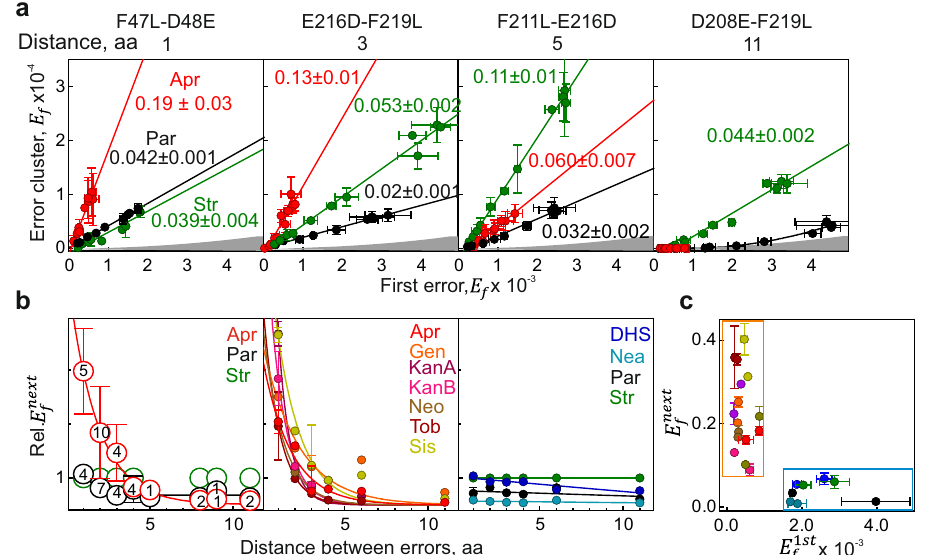
Fig. 5 Distance dependence of successive errors. a Correlation between E 1st f and E cluster f for different AGAs and clusters. Slopes of the linear plots yield the E next n = 3). Expected stochastic level of error clusters is indicated as gray area. b Distance f values. Shown are means ± SD of three technical replicates ( dependence of error cluster formation. Left panel: Distance dependence E next f for Apr, Par, and Str. Data from Figs. 4a, d, 5a, and Supplementary Figs. 7a, 8. The probability for error cluster formation is normalized to that of Str value, which has very little distance dependence and is set to 1 ( ‘ Methods ’ ). The number of clusters is indicated inside the symbols. When more than one cluster per distance was inspected, mean values ± SD are shown. Middle and right panel: Distance dependence of error cluster formation for different AGA based on PRM measurements. For single clusters, a mean of technical replicates is shown ( n = 3). If two or more clusters were considered for a given distance, the symbols represent a mean ± SD. c Correlation between E 1st f and E next f for different AGAs. Data and color code are from ( b ). Only clusters with adjacent substitutions are considered (F47L-D48E; E241D-E242D). Shown are means ± SD of three technical replicates ( n = 3). See also Fig. 4a, d, Supplementary Figs. 7, 8, and Source data fi